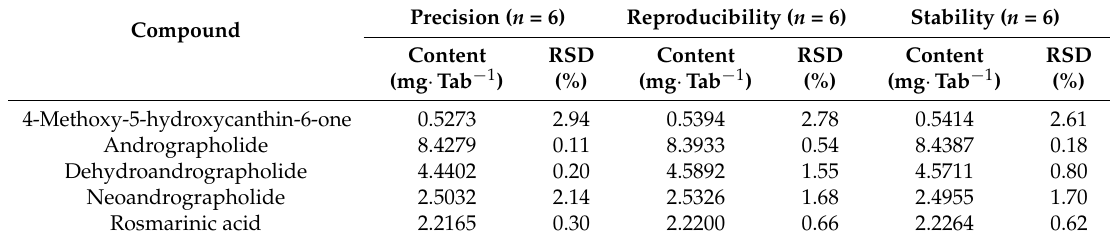
Table 2. Precision, reproducibility and stability for the analysis of the five bioactive compounds. Compound